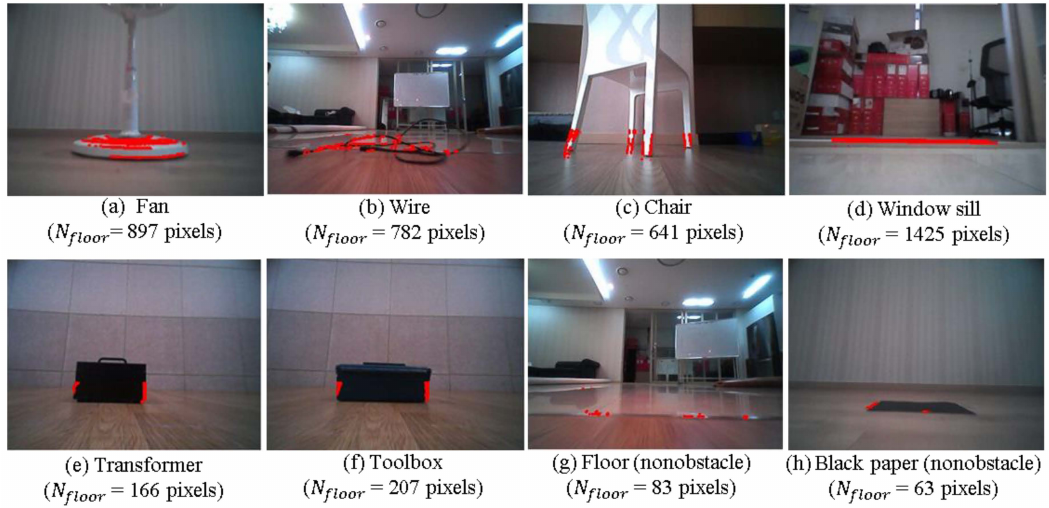
Figure 5. IPM-based obstacle detection results for various cases. Few obstacles are detected for the case of the transformer and toolbox in panels ( d ) and ( e ), whereas few obstacles are detected in the floor region in panels ( f ) and ( g